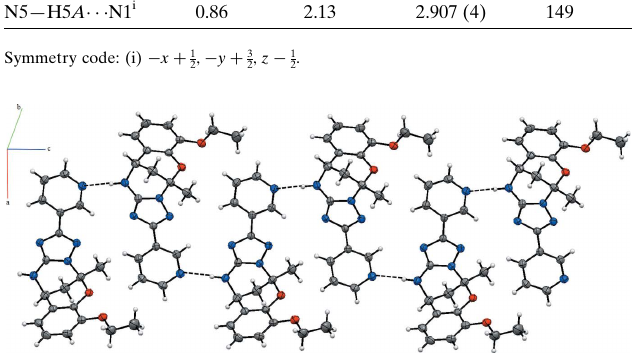
Figure 2 A partial view of the crystal packing of the title compound. Dashed lines